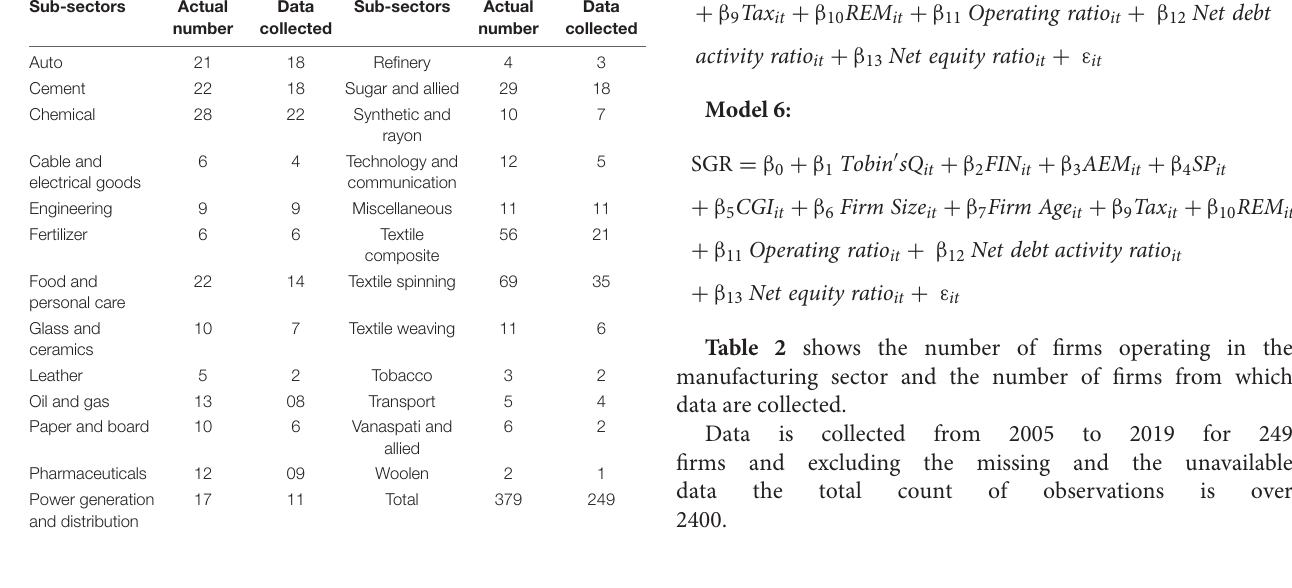
TABLE 2 | Actual number of firms and number of firms whose data is available. Sub-sectors Actual Data Sub-sectors Actual Data number collected number collected